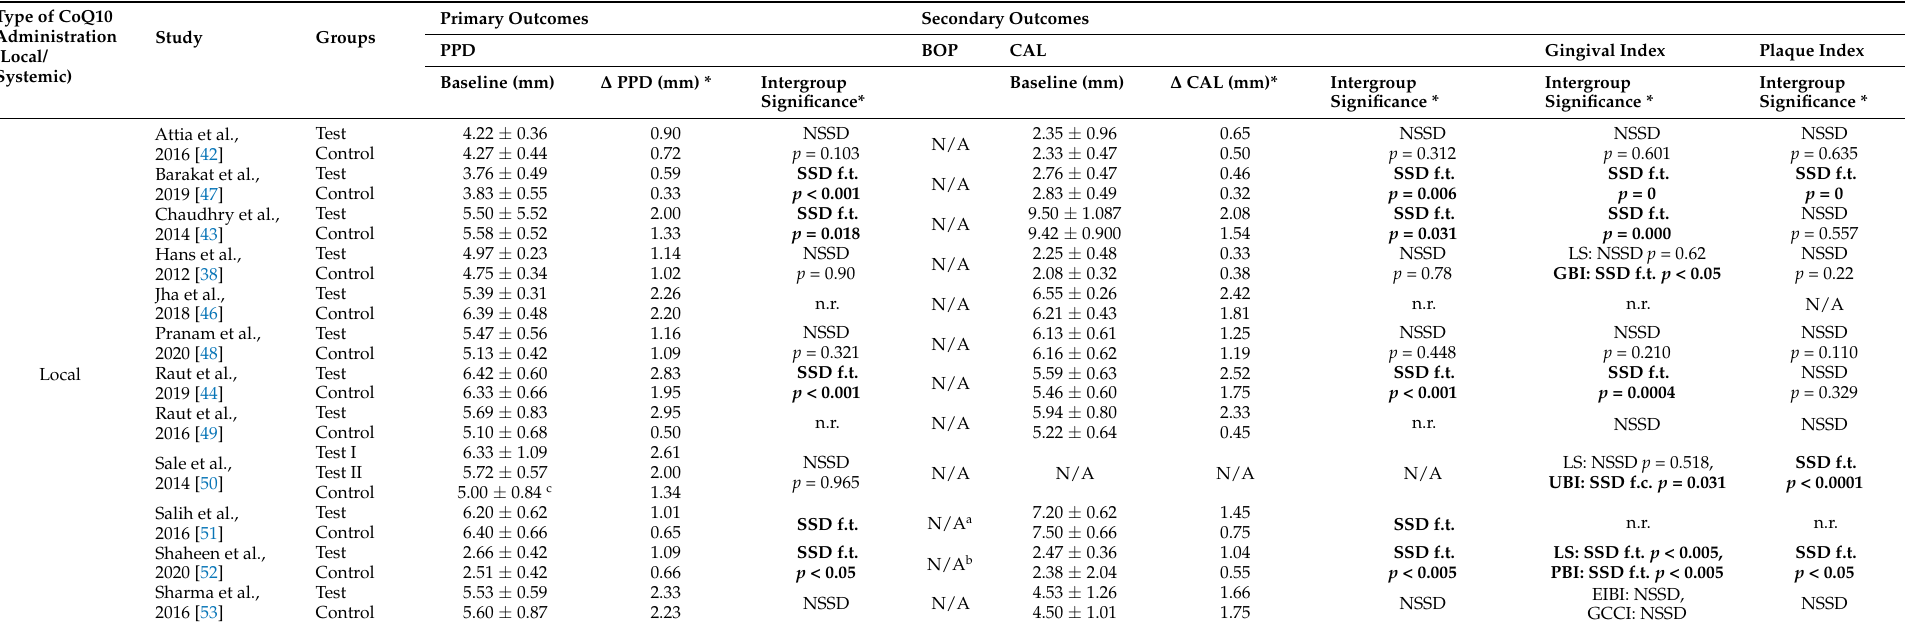
Table 3. Outcomes of the included studies with the difference between baseline and study end ( ∆ ) for periodontal probing depths (PPD), bleeding on probing (BOP), and clinical attachment loss (CAL) if applicable. Intergroup significances at the study end are presented for all outcomes (additionally for gingival index and plaque index). Bold marks significant